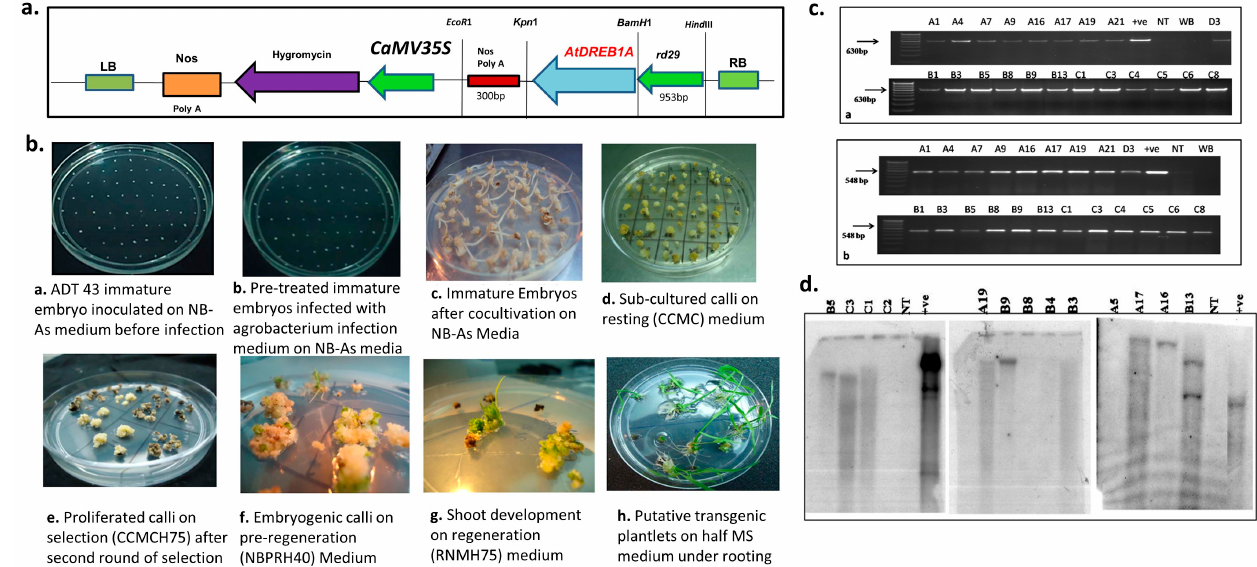
Figure 1. Development of transgenic rice (ADT 43) lines and molecular analysis ( a ) map of pCAMBIA 1300 harboring AtDREB1A under the control of stress-inducible promoter rd29A ( b ) Agrobacterium-mediated transformation of rice (ADT 43) ( c ) PCR analysis of transgenic and non-transgenic (NT) ADT 43 lines showing the amplification of hygromycin ( hpt) gene (630 bp) and AtDREB1A gene (548 bp), WB—Water Blank ( d ) Southern hybridization analysis of transgenic and non-transgenic ADT 43 lines; 25 µ g genomic DNA digested with BamHI and transferred to nylon membrane and hybridized with radiolabeled hygromycin probe. Blots show different transgenic, non-transgenic (NT), and positive plasmid-harboring AtDREB1A (+ve).